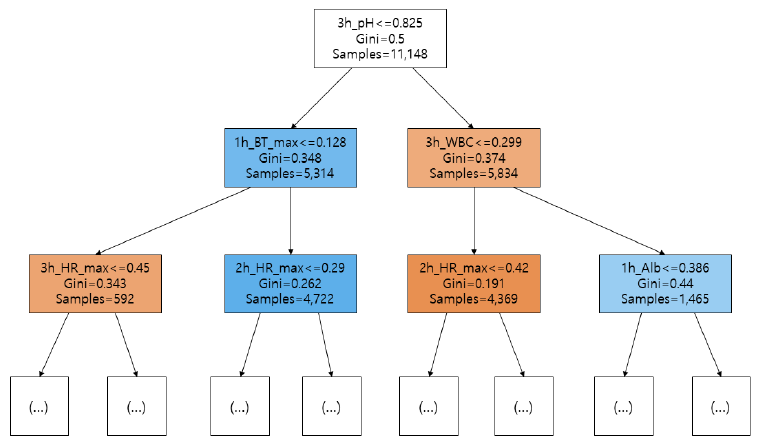
Figure 8. Decision tree. Orange indicates the prediction of respiratory failure in each node. Blue indicates non-respiratory failure. Darker nodes contain more data.